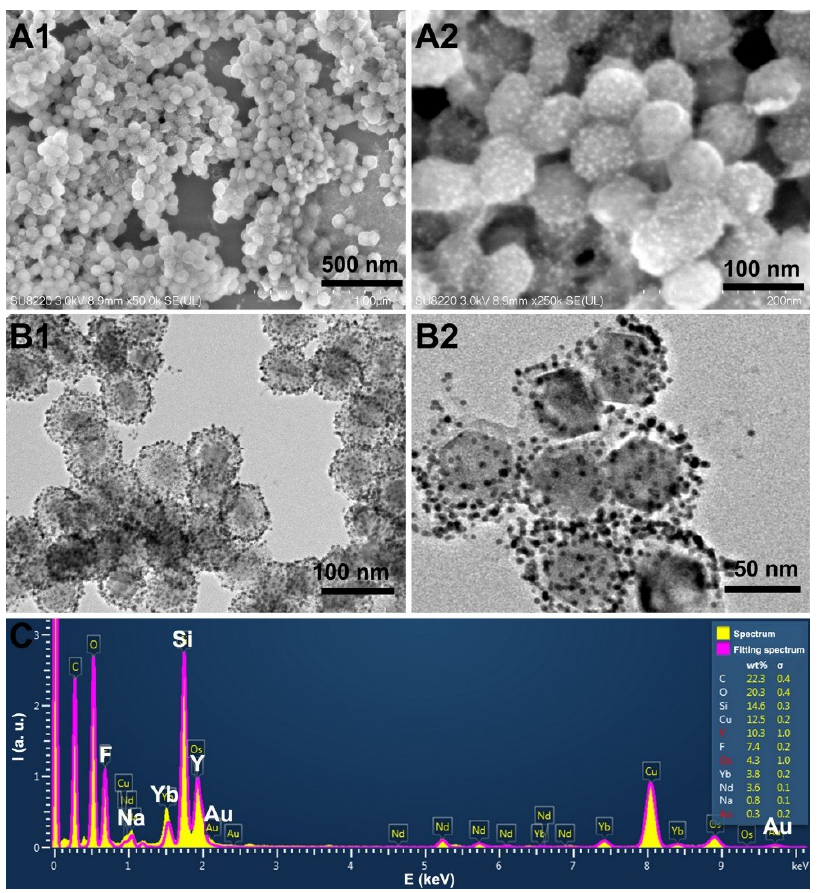
Figure 2. ( A1 , A2 ) SEM images at different magnifications, ( B1 , B2 ) TEM images at different magnifications, and ( C ) EDS result of UCNP@mSiO 2 -Au NPs ( R 1 = 15 nm, D = 15 nm, Z = 2–4 nm), in which the intensity peaks in the I(E) curve correspond to the differences in energy E between two states of the electron shell which are characteristic to the atomic structure of the emitting element.